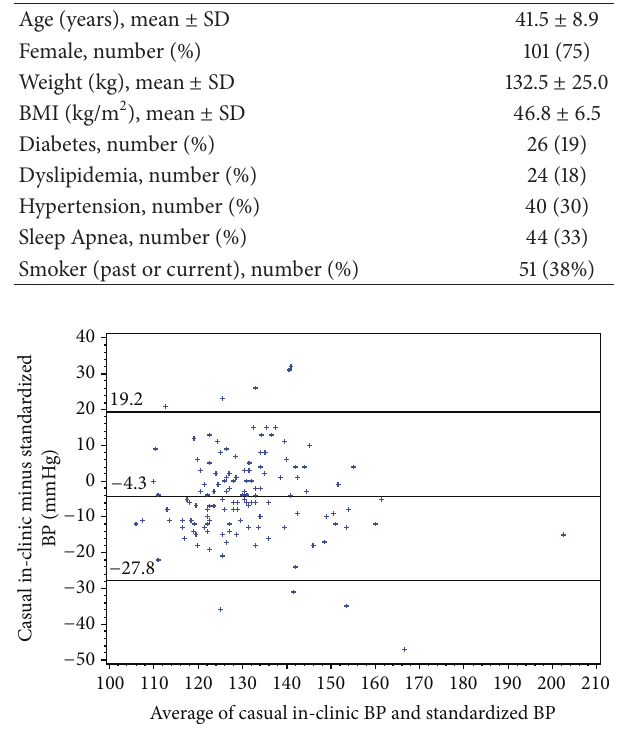
Figure 1: Bland-Altman plot assessing agreement for systolic blood pressure.